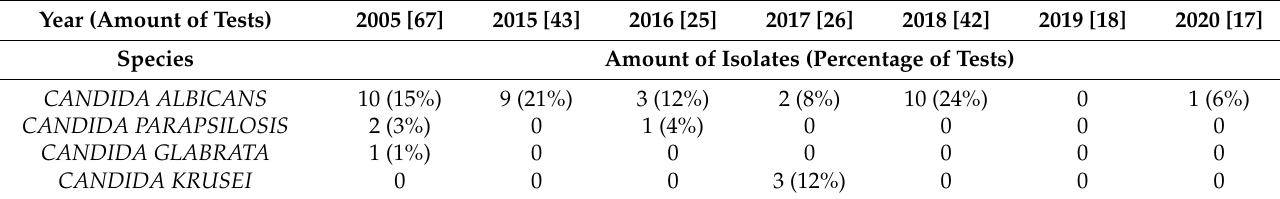
Table 8. Yeast species isolated in NICU patients from the urinary tract.